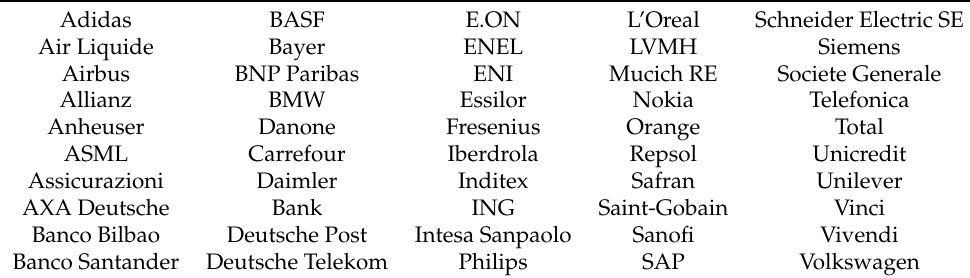
Table 1. List of European stocks under analysis (by alphabetic